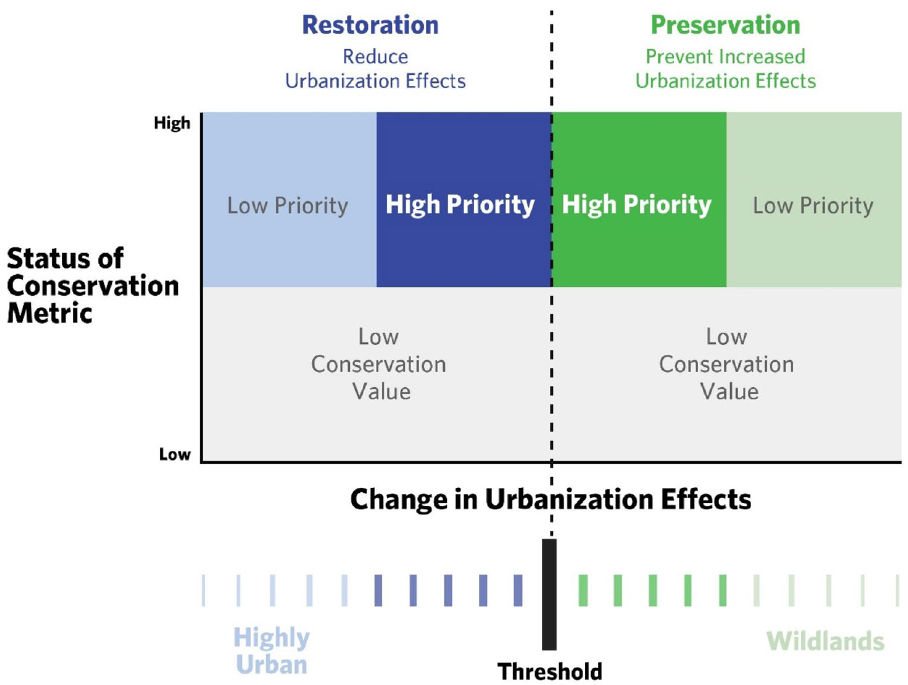
Figure 1. Conceptual framework for prioritizing restoration and preservation actions, using an ecological or utility threshold (dashed black line) to distinguish between restoration locations (blue, where negative effects of urbanization need to be reduced to reach the threshold) and preservation locations (green, where negative effects of urbanization should be prevented to avoid reaching the threshold). The prioritization is guided by the location of the threshold and the status of a relevant conservation metric. Locations with a high status of the conservation metric and those closer to the threshold are higher priority for conservation action (darker shades) compared to those further away (lighter shades) because the x -axis is a proxy for effort. Restoration sites close to the threshold require less effort to mitigate the effects of urbanization to an appropriate level compared to more urban sites (far left). Preservation sites close to the threshold are at greater risk of exceeding the threshold than less developed sites and are therefore higher priority for preservation action. In our case study, the ecological threshold is the level of urbanization effects associated with the critical level of coho pre-spawn mortality ( M crit ), and we evaluate two different conservation metrics: amount of habitat for coho and for Chinook. A high conservation metric status equates to a large amount of habitat, whereas low status equates to little